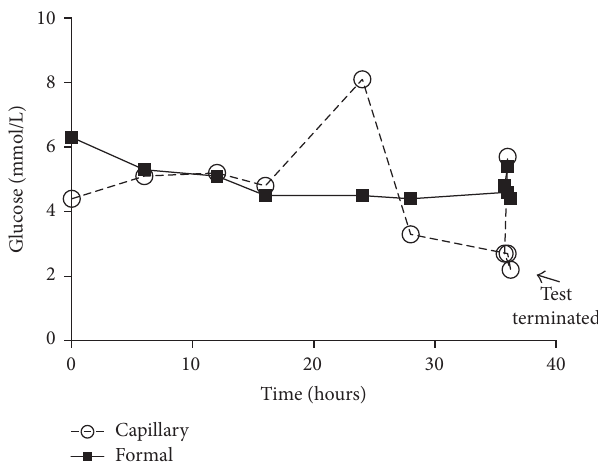
Figure 1: A seventy-two-hour fast protocol revealed a discrepancy between capillary (point-of-care glucometer) and venous blood glucose levels. The test was terminated early due to low capillary glucose levels (2.2